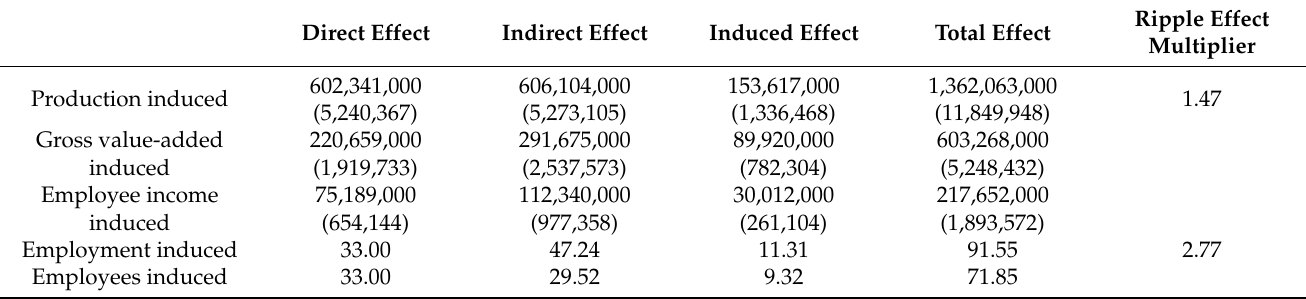
Table 6. Economic ripple effects of the GLT sector (after unifying two sectors’ self-sufficiency; unit: JPY (USD), people).